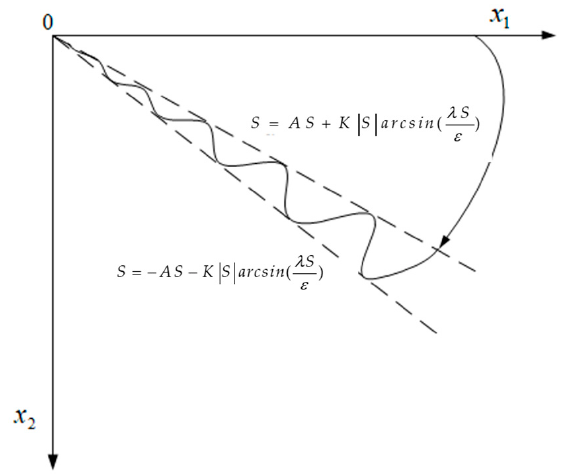
Figure 2. Improved sliding mode approach phase trajectory.